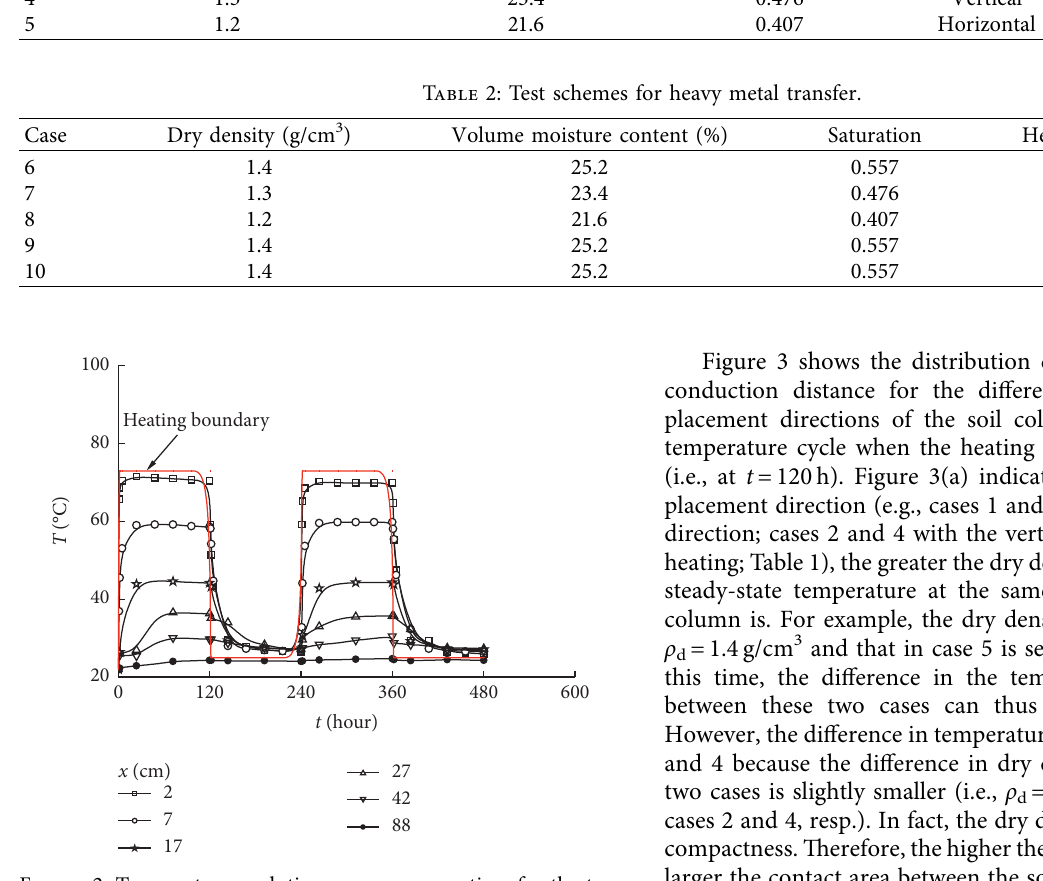
Figure 2: Temperature evolution processes over time for the two heating